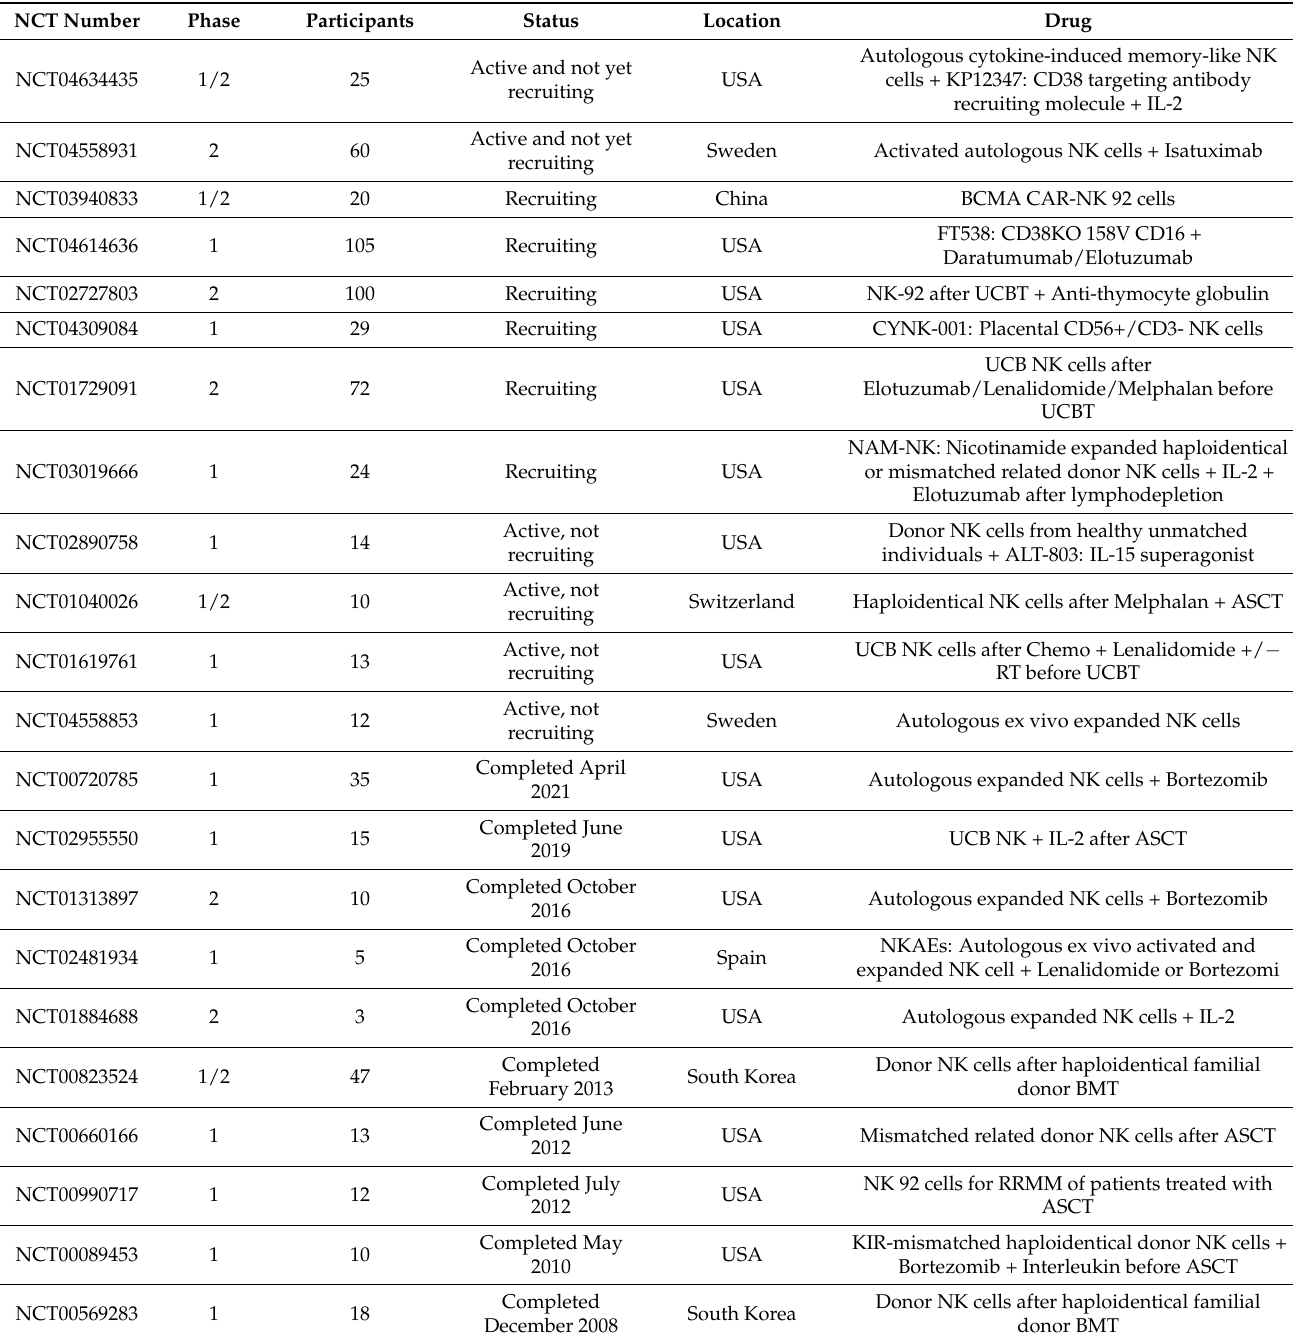
Table 1. The list of actual clinical trials for NK cell therapies in